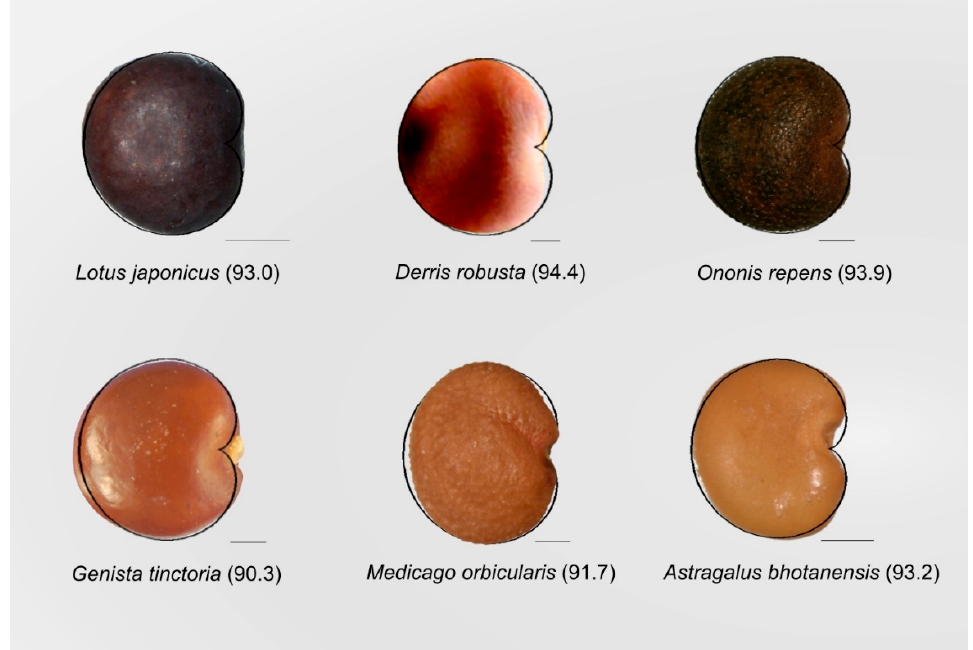
Figure 10. The cardioid can be used for seed shape quantification in many species of legumes, including the model species Lotus japonicus . The values indicated correspond to J index in the images shown and do not represent mean values for each particular species. Bar equals 0.5 mm.